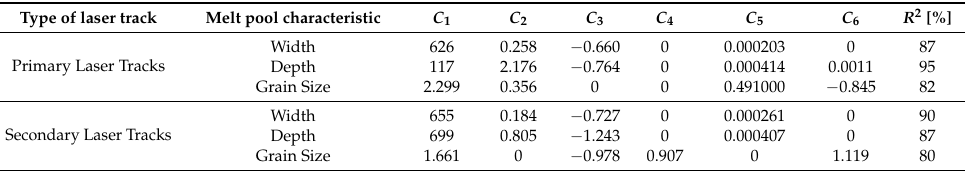
Figure 7. Melt pool width and depth for secondary laser tracks . Topographical representation based on the regression data. Data points of the full factorial design, which were used for the regression, are marked by squares. Data points of the single parameter variations marked by triangles and rhombs. Table 2. Coefficients for the quadratic regression model visualized in Figures 6–8. The quality of the derived equation is quantified by the coefficient of determination R 2